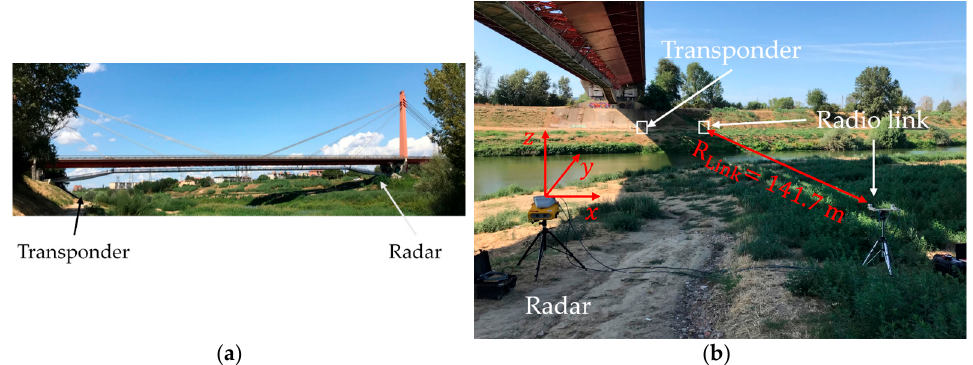
9 of 12 Figure 13. Amplitude image registered by radar and by transponder using the radio link. 3.3. Case study—Indiano Bridge, Florence, Italy The multi-monostatic interferometric radar with radio link was tested at Indiano Bridge, Florence, Italy. This bridge is an earth-anchored, cable-stayed bridge, and it was built between 1972 and 1978.